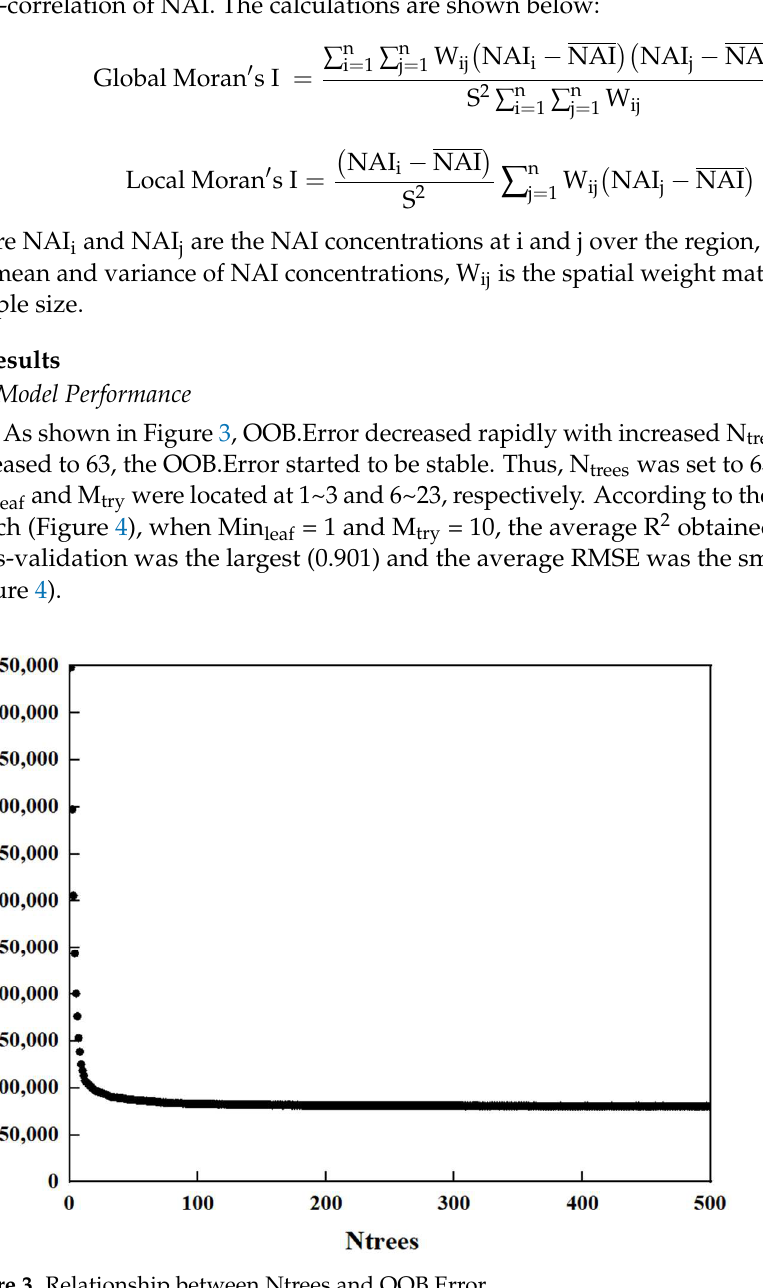
Figure 4. R 2 ( a ) and RMSE ( b ) for different combinations of Min leaf and M try. Models were built based on “optimal” parameters and training samples, and model training and validation were also performed (Figure 5). In the model training process, R 2 , RMSE, and bias for the model were 0.986, 109.039, ions cm −3 , and 0.815 ions cm −3 , respec- tively. In the validation process, R 2 = 0.878, RMSE = 258.617 ions cm −3 , and bias = 14.973 ions cm −3 , respectively. The efficiency of the model was evaluated for NAI > 4000 ions cm −3 , and the R 2 and bias reached 0.68 and 321.90 respectively. These results proved an excellent model performance to be applied regionally.